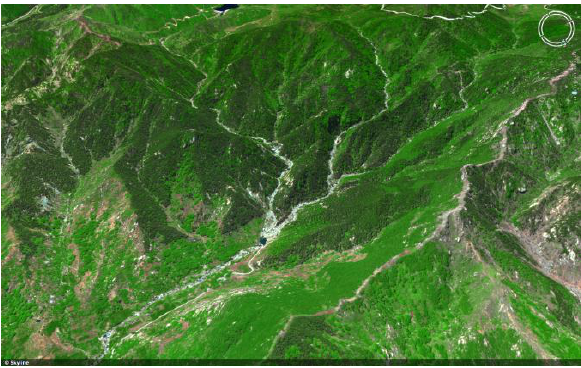
Figure 9. Longwan canyon landform